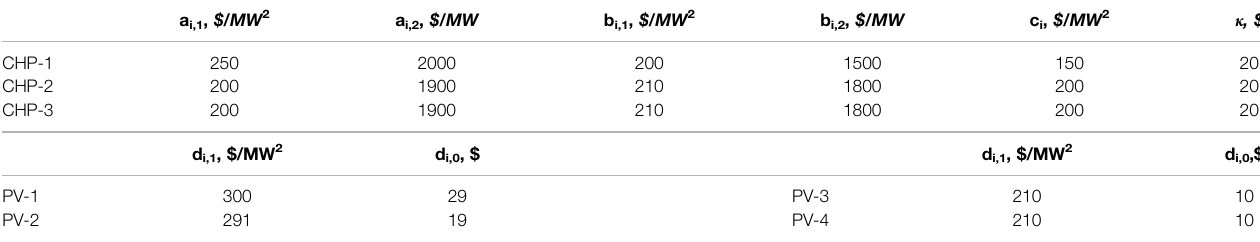
TABLE 2 | Operation cost parameters of 3-CHPs and